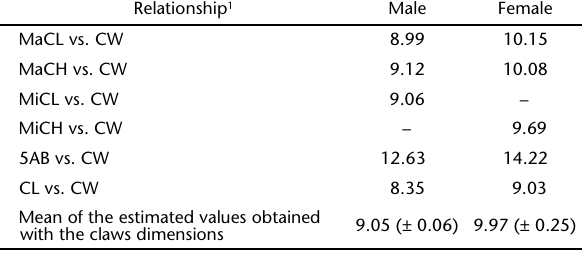
Table IV. Trichodactylus fluviatilis . Average carapace width size (mm) at onset of maturity, regarding the biometric relationships